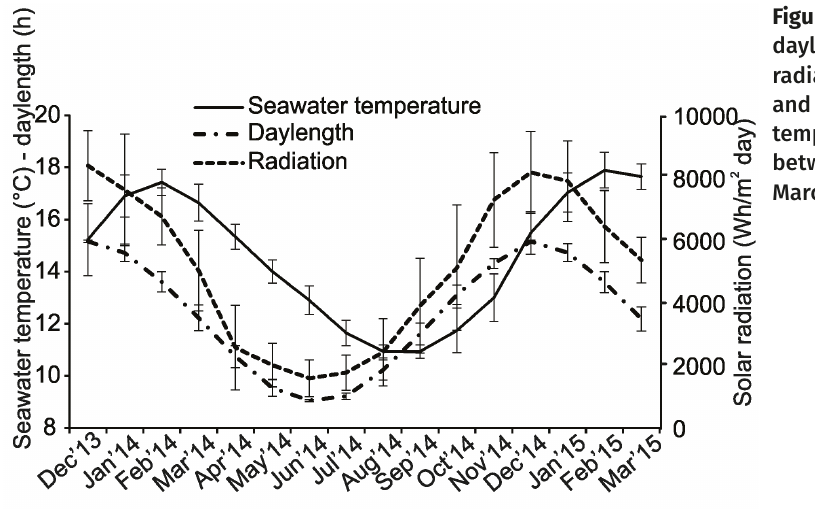
Figure 1. Variation in daylength (hours),